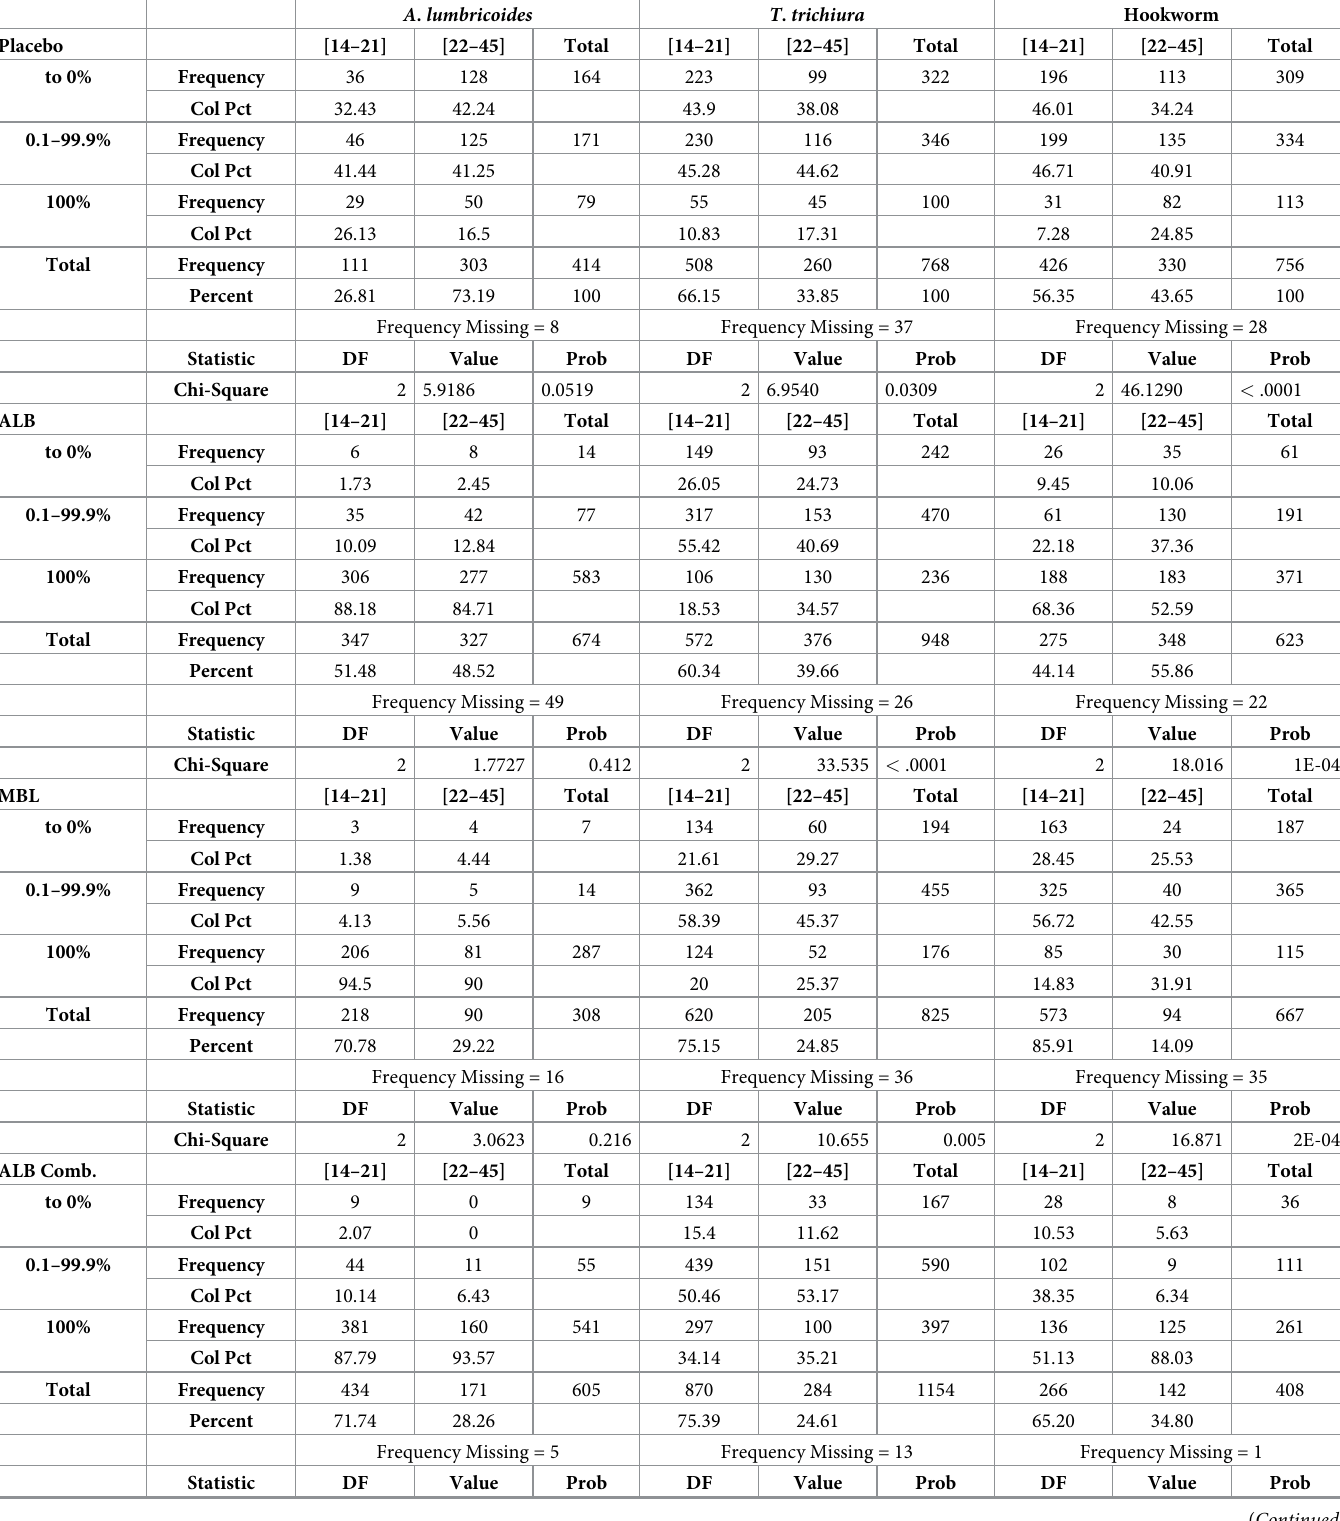
Table 8. Frequency of individual ERR per STH species and duration of